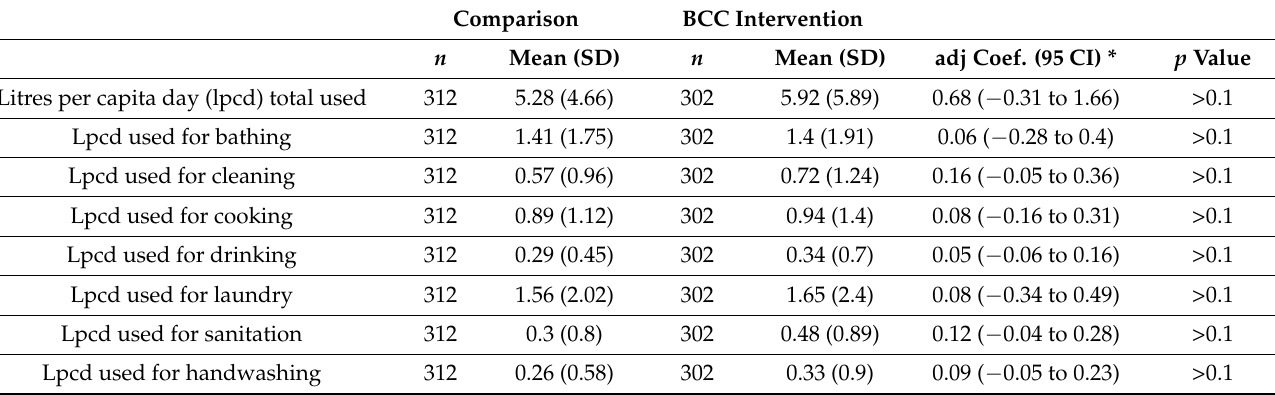
Table 5. Water use outcomes in